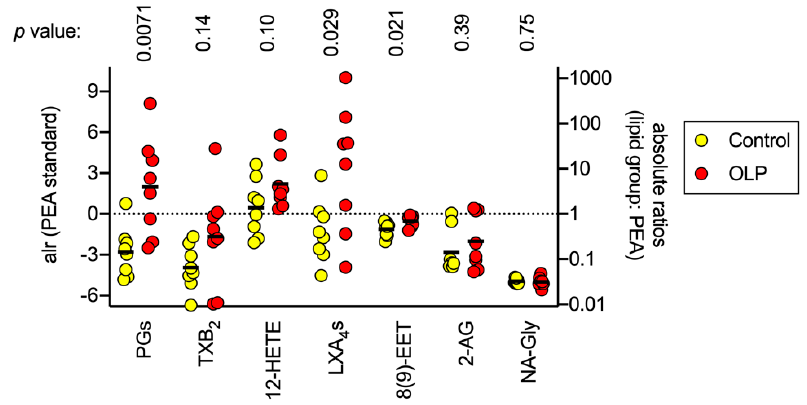
Figure 5. Additive log ratios (alr) with PEA as the denominator for PGs, TXB 2 , 12-HETE, LXA 4 s, 8(9)-EET, 2-AG and NA-Gly in the control and OLP biopsy samples. The additive log ratios (alr) with PEA as the denominator, i.e., ln(lipid / [PEA]) are given on the left y axis, with the corresponding anti-logged absolute ratios shown on the right y axis. The solid bars represent the means. The p values were determined by two-tailed t -tests not assuming equal variances. The critical value of p at a 5% false discovery rate is 0.0071.